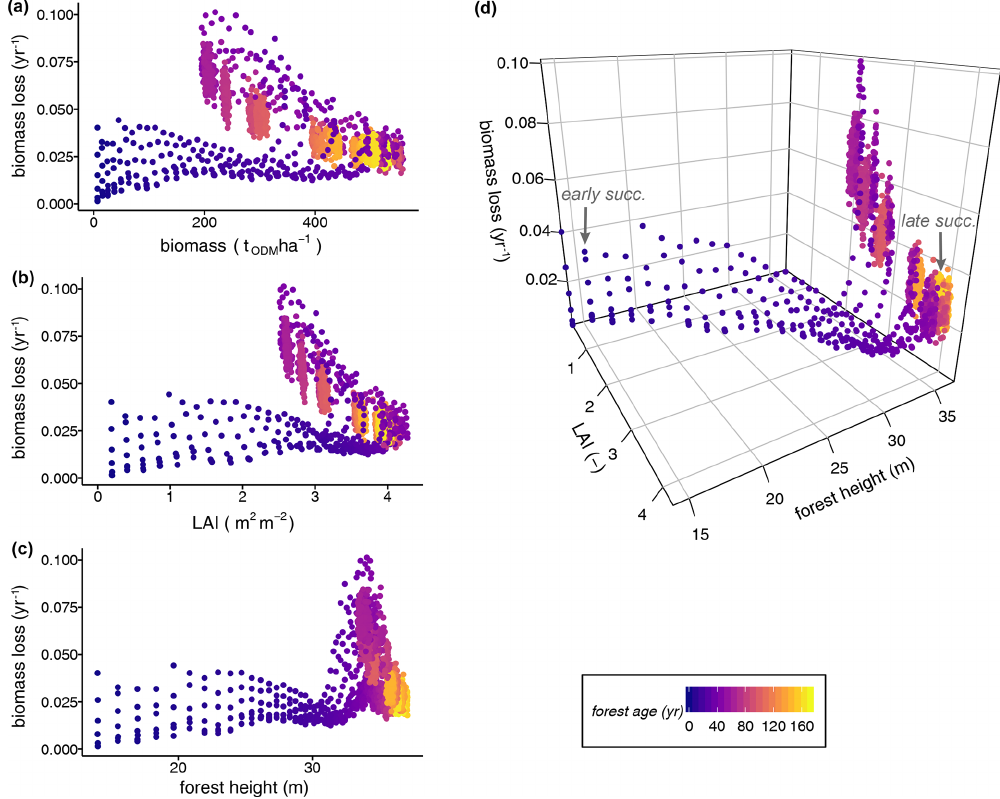
Figure 5. Dependence of biomass loss rates from the single attributes (a) biomass, (b) LAI, and (c) forest height versus (d) the multiple forest attributes (LAI and forest height) of simulated forest states, including all stem mortality scenarios. Each dot represents a terra firme forest stand with a unique forest structure (i.e. tree size distribution and functional species composition). All simulated years are included in the analyses. The colours of the dots show the mean forest ages characterizing the successional states (ODM: organic dry matter).